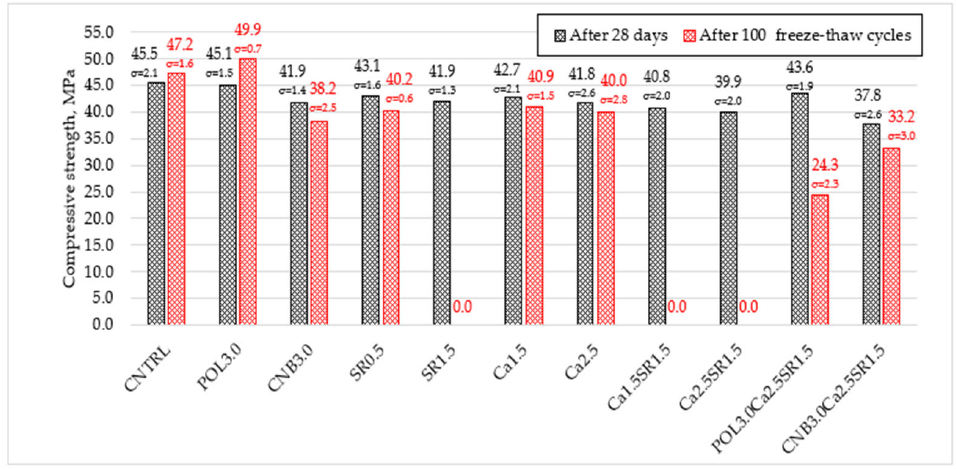
Figure 13. The change in compressive strength of concrete after 100 freeze ‐ thaw cycles.